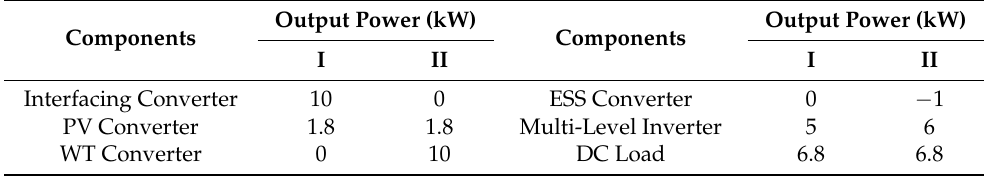
Table 8. Output power of each power conversion devices in mode 8.